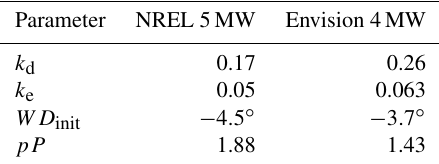
Table 1. FLORIS wake tuning.